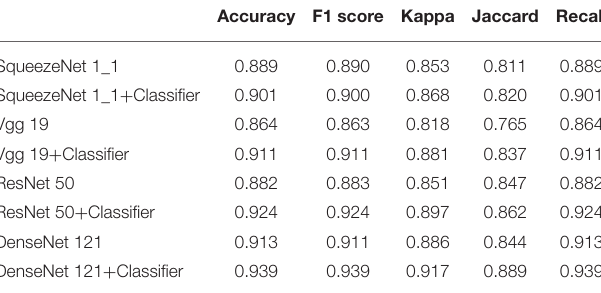
TABLE 6 | Ablation experiment of proposed